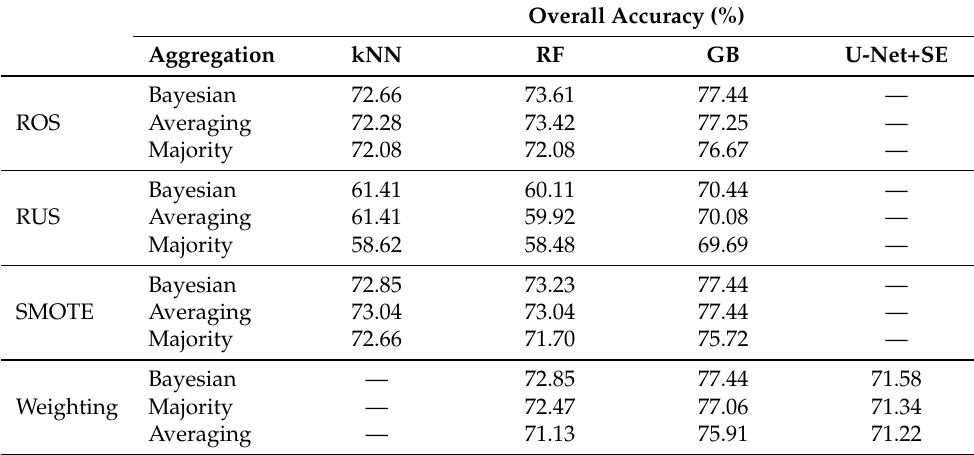
Table 3. Comparison of different aggregation techniques and resampling techniques for field-based crop classification by ML models and U-Net. The table does not contain metrics for resampling methods incompatible with some algorithms. For example, ROS, RUS, and SMOTE methods are not applicable for CNN, and weighting is not for kNN. Bold text indicates the best overall accuracy for each of the resampling methods. For all methods, the Bayesian strategy of pixel aggregation improved overall